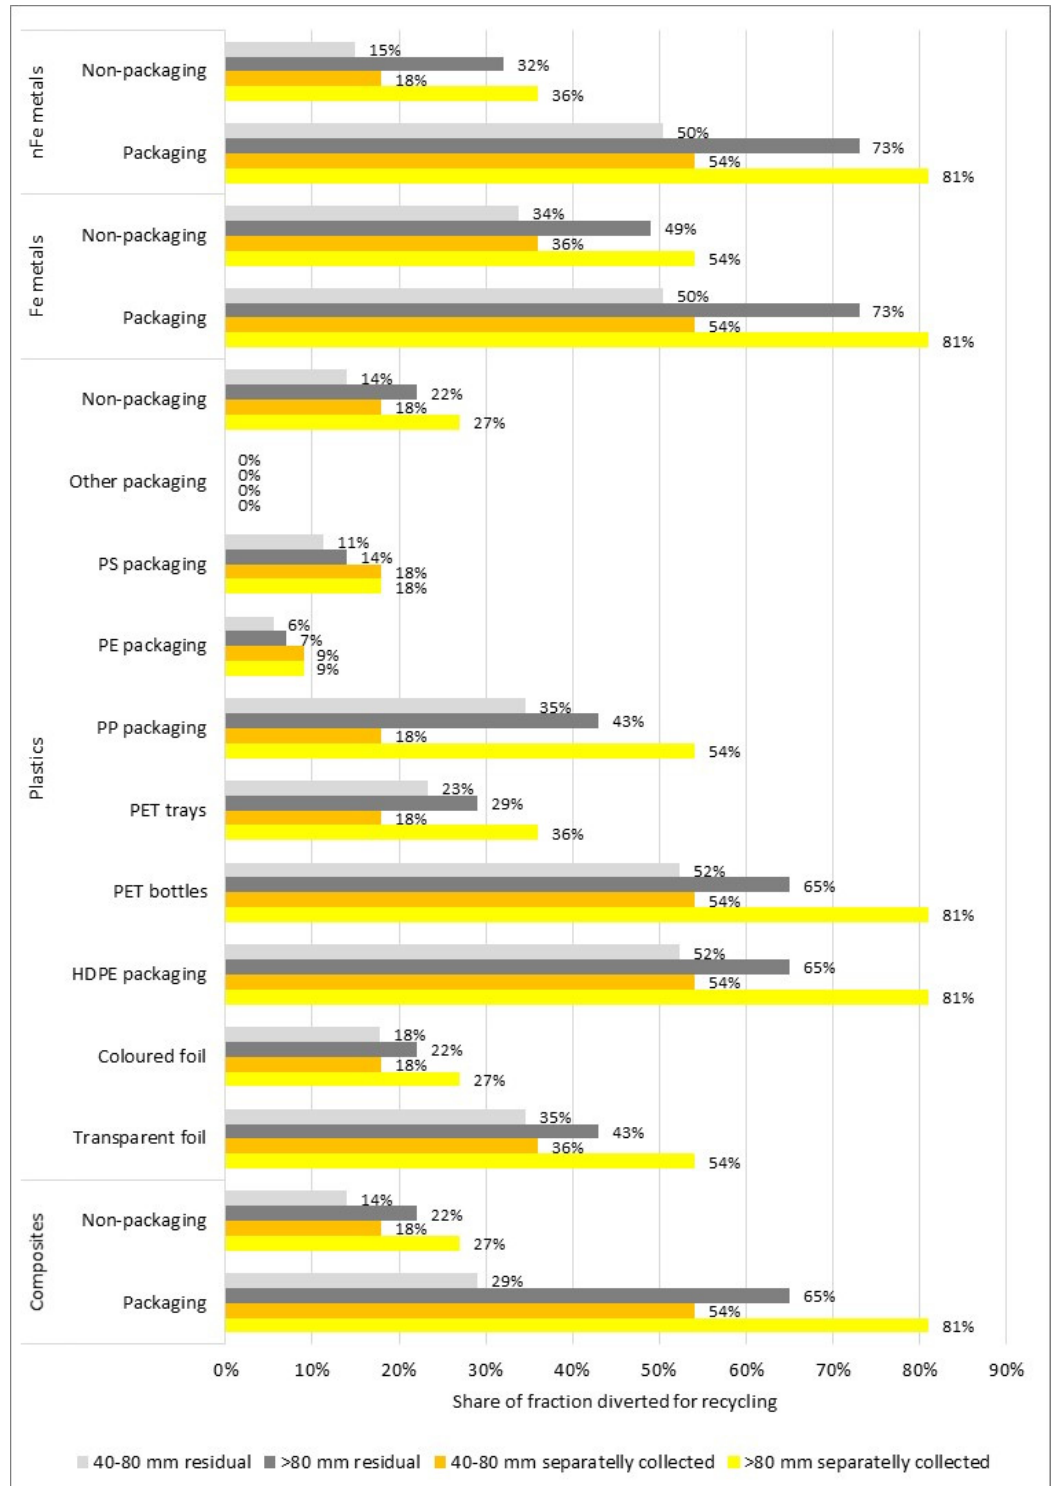
Figure 10. Assumed shares of materials diverted for recycling from different waste fractions.